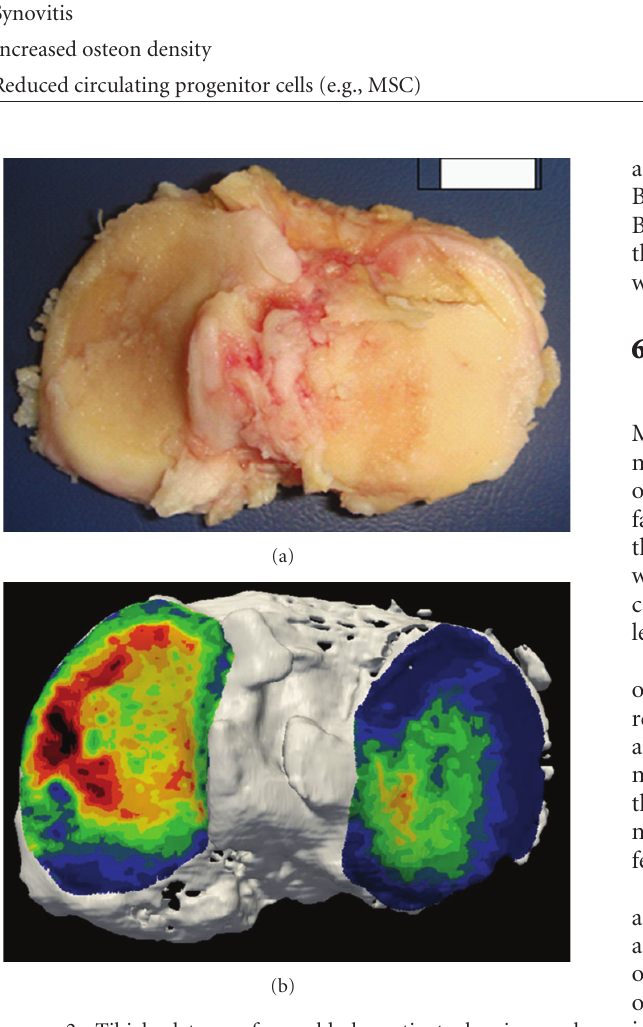
Figure 2: Tibial plateau of an elderly patient showing end- stage OA with complete cartilage loss (a). Computed tomography osteoabsorptiometry (CT-OAM) indicates high bone density in red